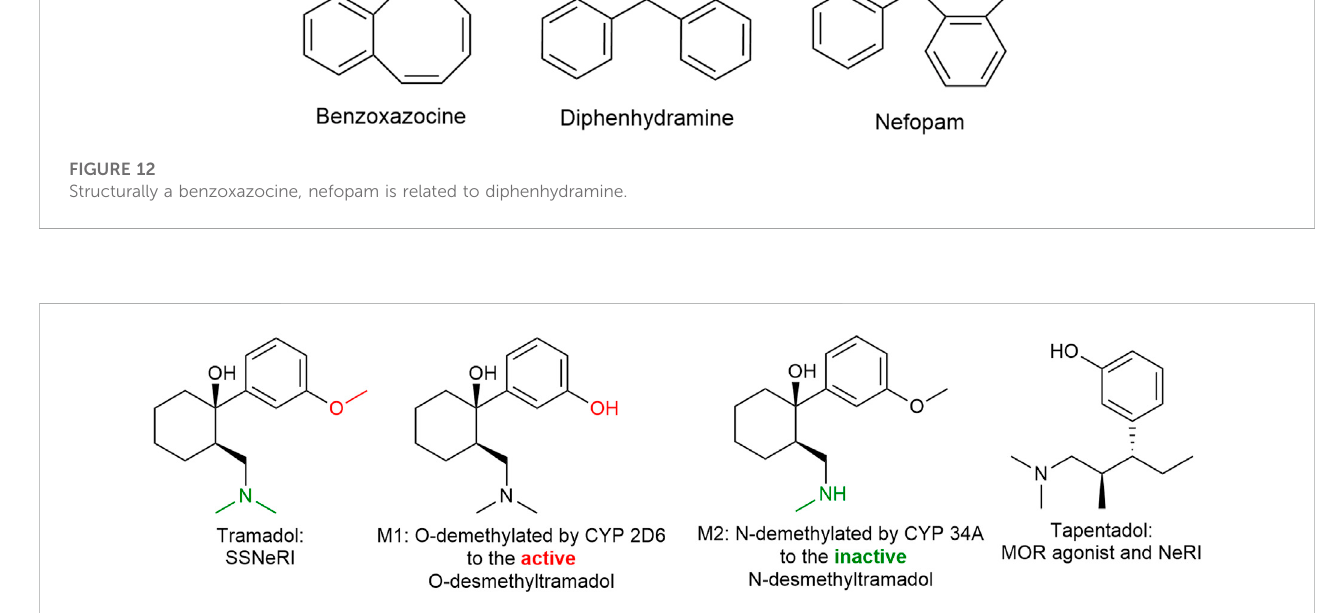
FIGURE 13 Tramadol and tapentadol are similar in their inhibition of norepinephrine reuptake. Tapentadol is also a more potent µ-opioid receptor agonist than tramadol. SSNeRI: selective serotonin and norepinephrine reuptake inhibitor, MOR: µ-opioid receptor, and NeRI: norepinephrine reuptake